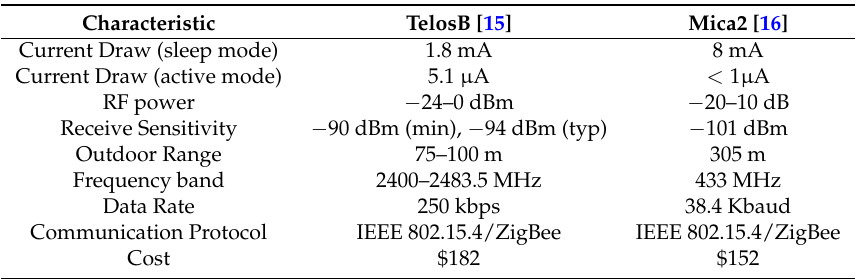
Table 2. Mica2 and TelosB hardware